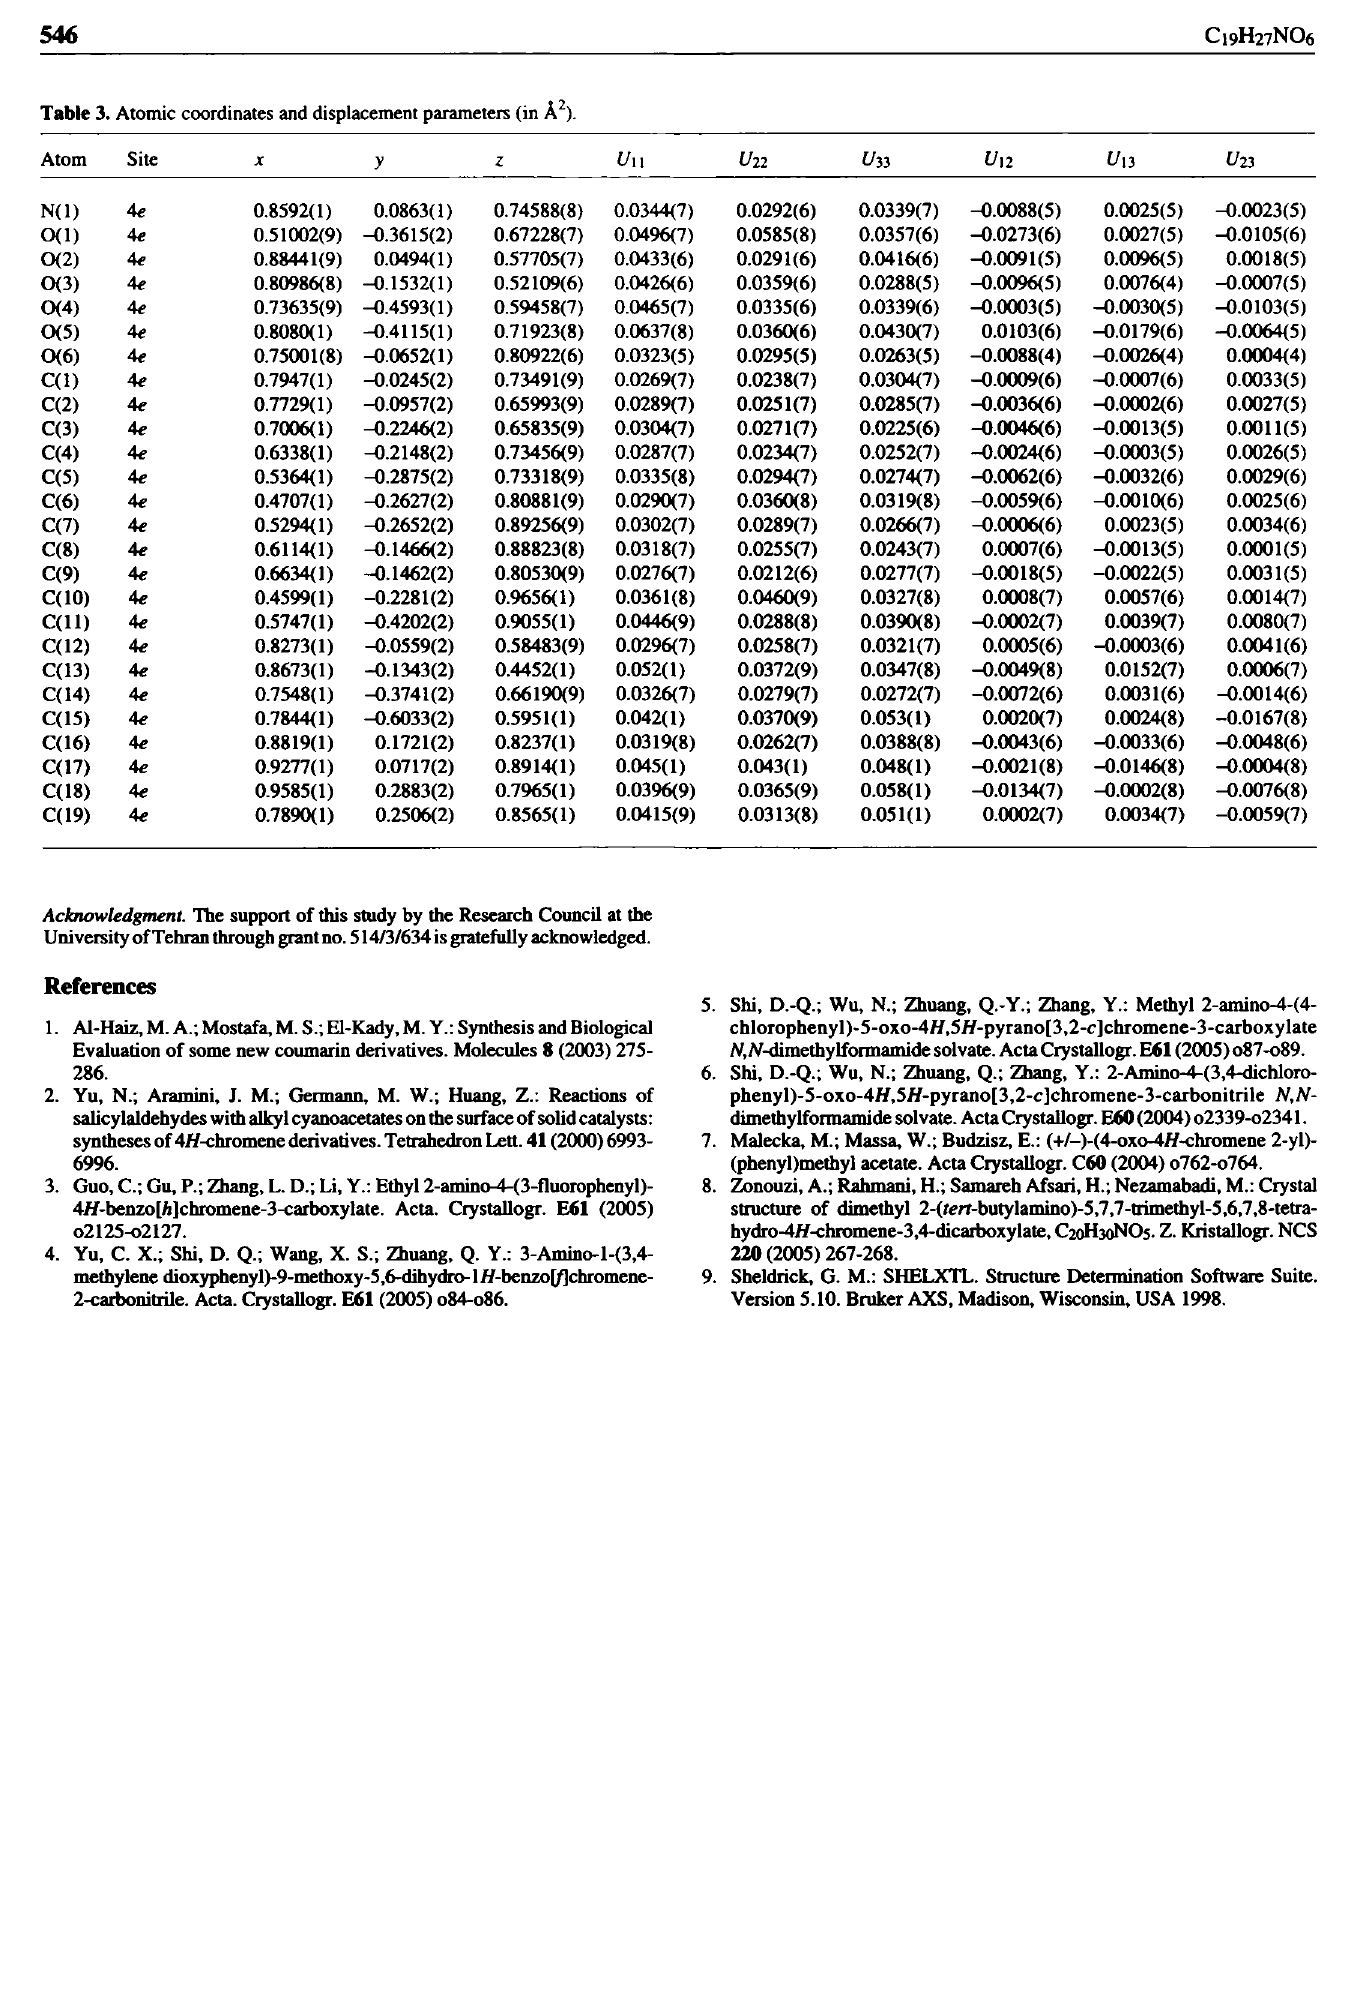
Table 3. Atomic coordinates and displacement parameters (in A 2